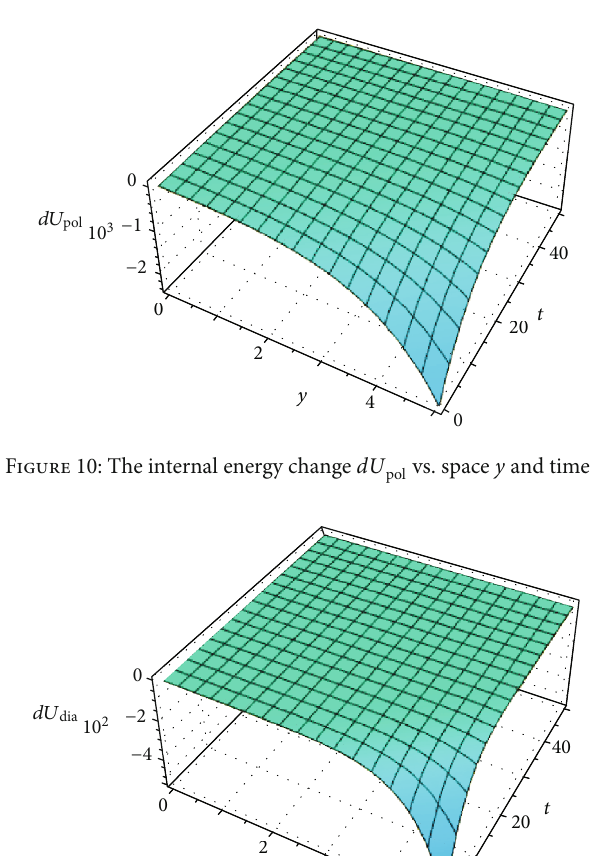
vs. space y and time t . dia